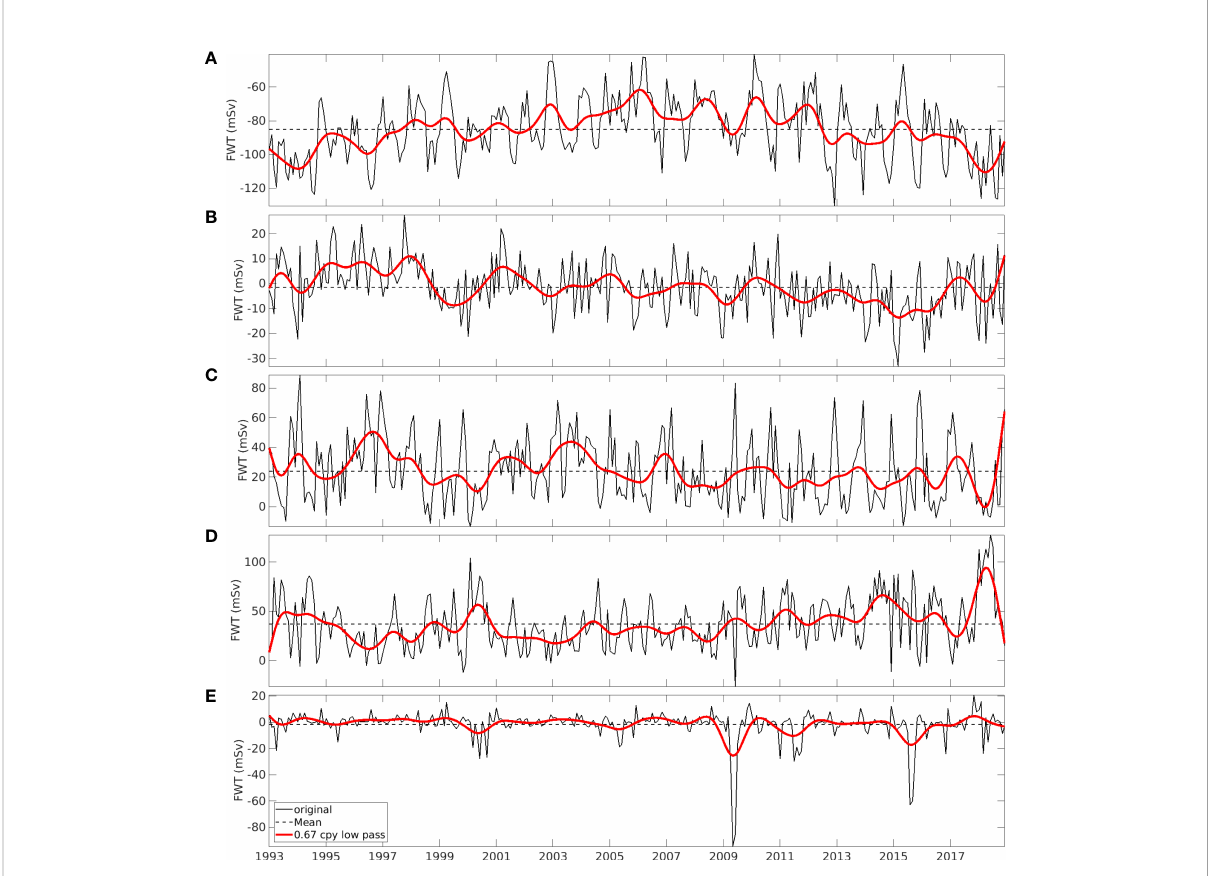
FIGURE 7 Monthly time series (black curve) of FWT through the boundaries (A-D) of the control volume and section (E) , superimposed with the low pass fi ltered time series (red curve) with a cut-off period of 1.5 years. The dashed lines indicate the time-mean values of the corresponding monthly time